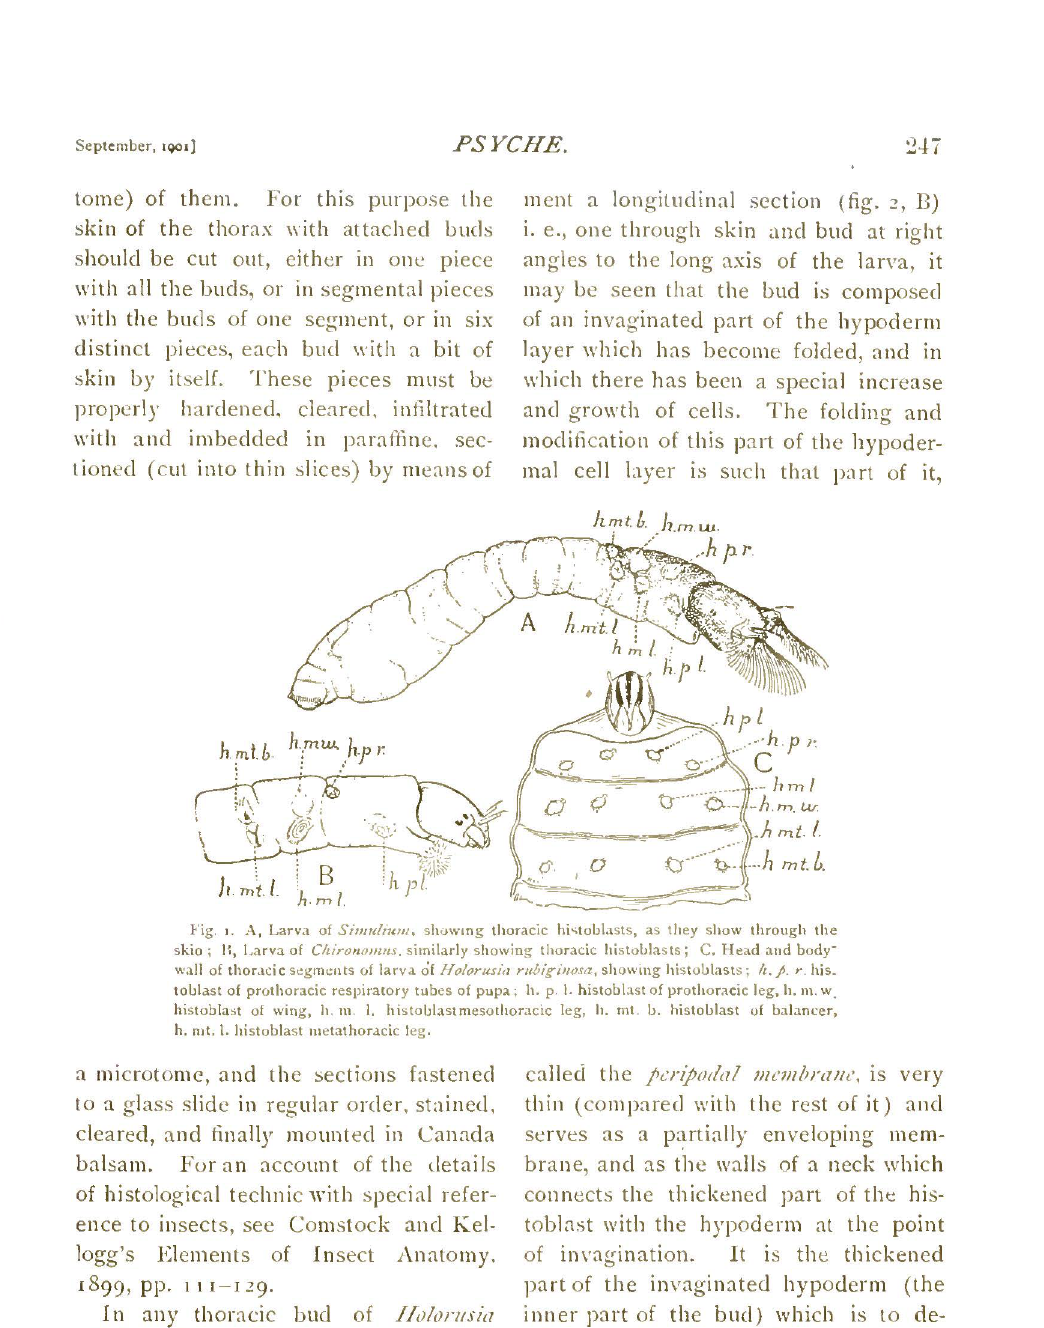
Fig. 1. A, Larva of Simulium, showmg thoracic hi..,toblasts, as they show through the skio ; H, Larva of Cltironomus. similarly showing thoracic histoblasts; C. Head and body wall of thor.tci c St!gmcnts of larva Of Holorusia ruln"g-in.osa, sho\\'ing histoblasts; k. }. r. his. to blast of prothoracic respiratory tubes of pupa; h. p. I. histoblast of protlwril.cic leg, h.m. w. histoblast of wing, h. m. I. histoblastmesothoracic leg, h. mt. b. histoblast uf balancer, h. mt. l. histoblast metathoracic